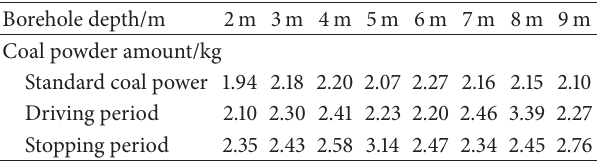
Table 3: Coal powder amounts at different borehole depths of 1412 working